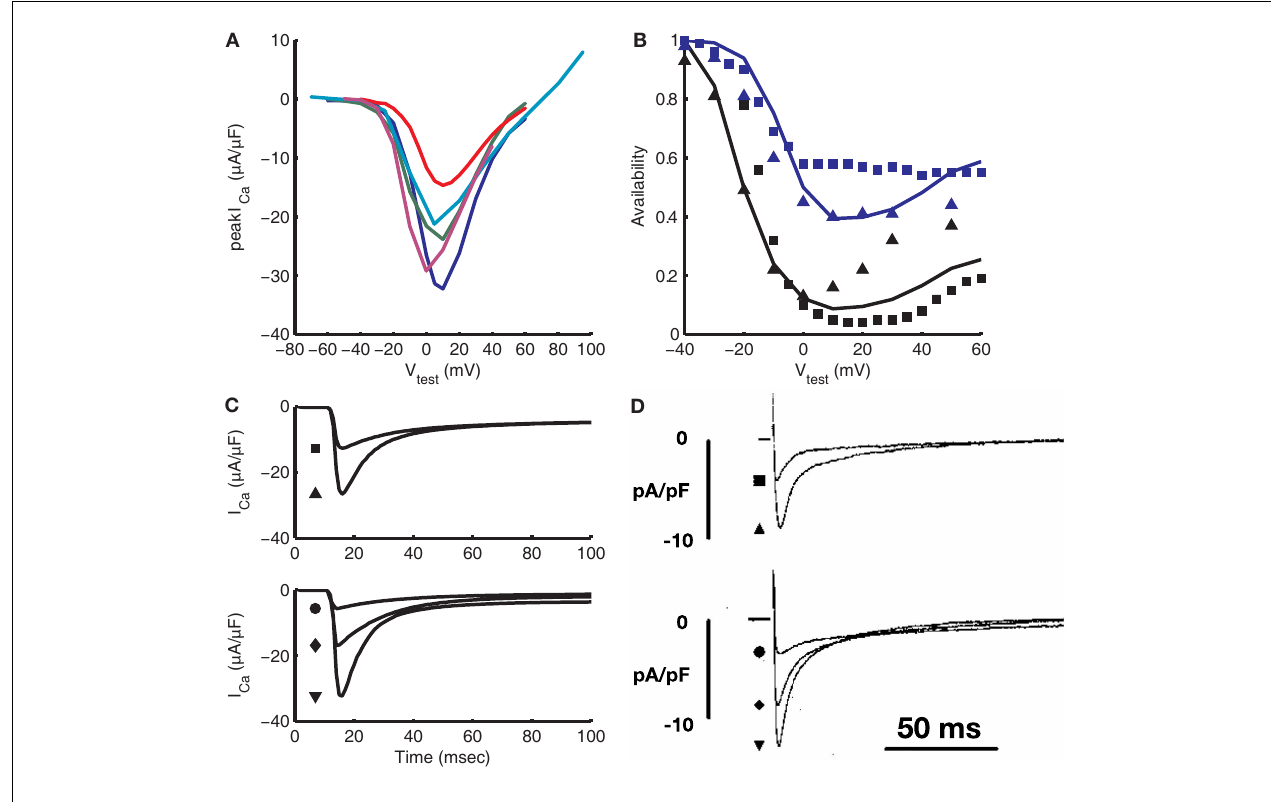
squares) and Hadley and Lederer (1991; triangles). (C) Model traces of I Ca,L vs. time for 400ms test pulses from a pre-clamp of − 40mV. (D) Experimental I Ca,L traces from Linz and Meyer (1998), also from a pre-clamp of − 40mV. For the top set of traces in (C,D) , the square represents a test potential of − 10mV and the triangle a test potential of 0mV. For the bottom set, test potentials are 10, 30, and 50mV for the circle, diamond, and triangle, respectively. (D) Was reproduced with copyright permission of JohnWiley and